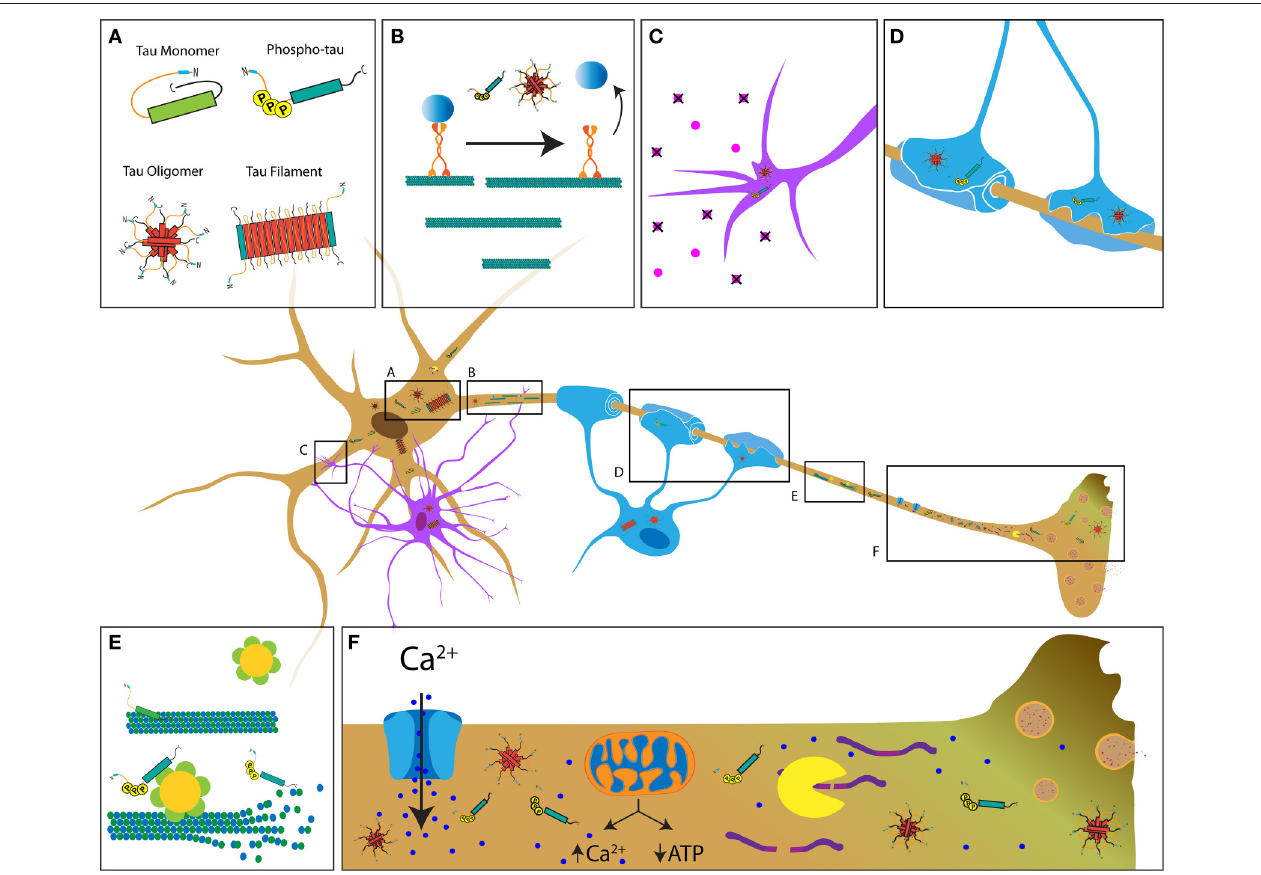
FIGURE 1 | Potential mechanisms contributing to tau-induced axonal degeneration in tauopathies. (A) Pathological forms of tau include phosphorylated tau, tau oligomers, and tau filaments, all of which feature increased exposure of the PAD (blue region of tau) (Kanaan et al., 2011). In contrast, this domain is hidden in soluble tau monomers, which feature a paperclip conformation ( Jeganathan et al., 2008). Depending on the specific tauopathy, pathological tau is present in neurons (brown cell), astrocytes (purple cell, C ) and oligodendrocytes (blue cell, D ). (B) Pathological conformations of tau impair axonal transport through activation of a phosphotransferase-based signaling pathway that promotes detachment of transported cargoes from the motor protein conventional kinesin. (C,D) Accumulation of pathological tau may also interfere with cellular processes involved in trophic support by astrocytes and oligodendrocytes, ultimately resulting in axonal dysfunction and demyelination. (E) Disease-related modifications of tau (e.g., phosphorylation) that reduce its binding to microtubules may promote aberrant katanin-mediated microtubule severing. (F) Disease-related forms of tau can alter Ca 2 + homeostasis through various mechanisms, including abnormal modulation of ion